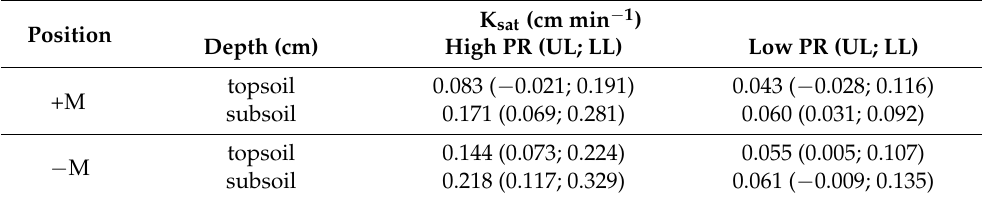
Table 3. Saturated hydraulic conductivity (mean, upper limit, and lower limit derived by GLMM) as a function of depth in high- and low-PR areas and for sites frequently crossed (+M) or non-crossed ( − M) by machinery. Confidence intervals have been computed with a 95% confidence level.